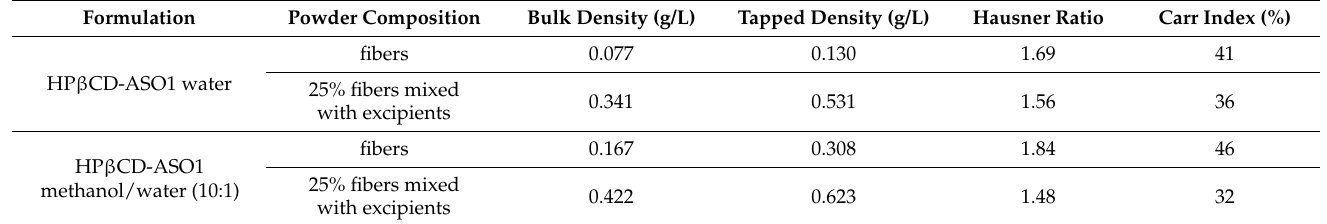
Table 4. Comparison of flowability: HP β CD containing formulations with different fiber morphology and their mixture with tableting excipients.